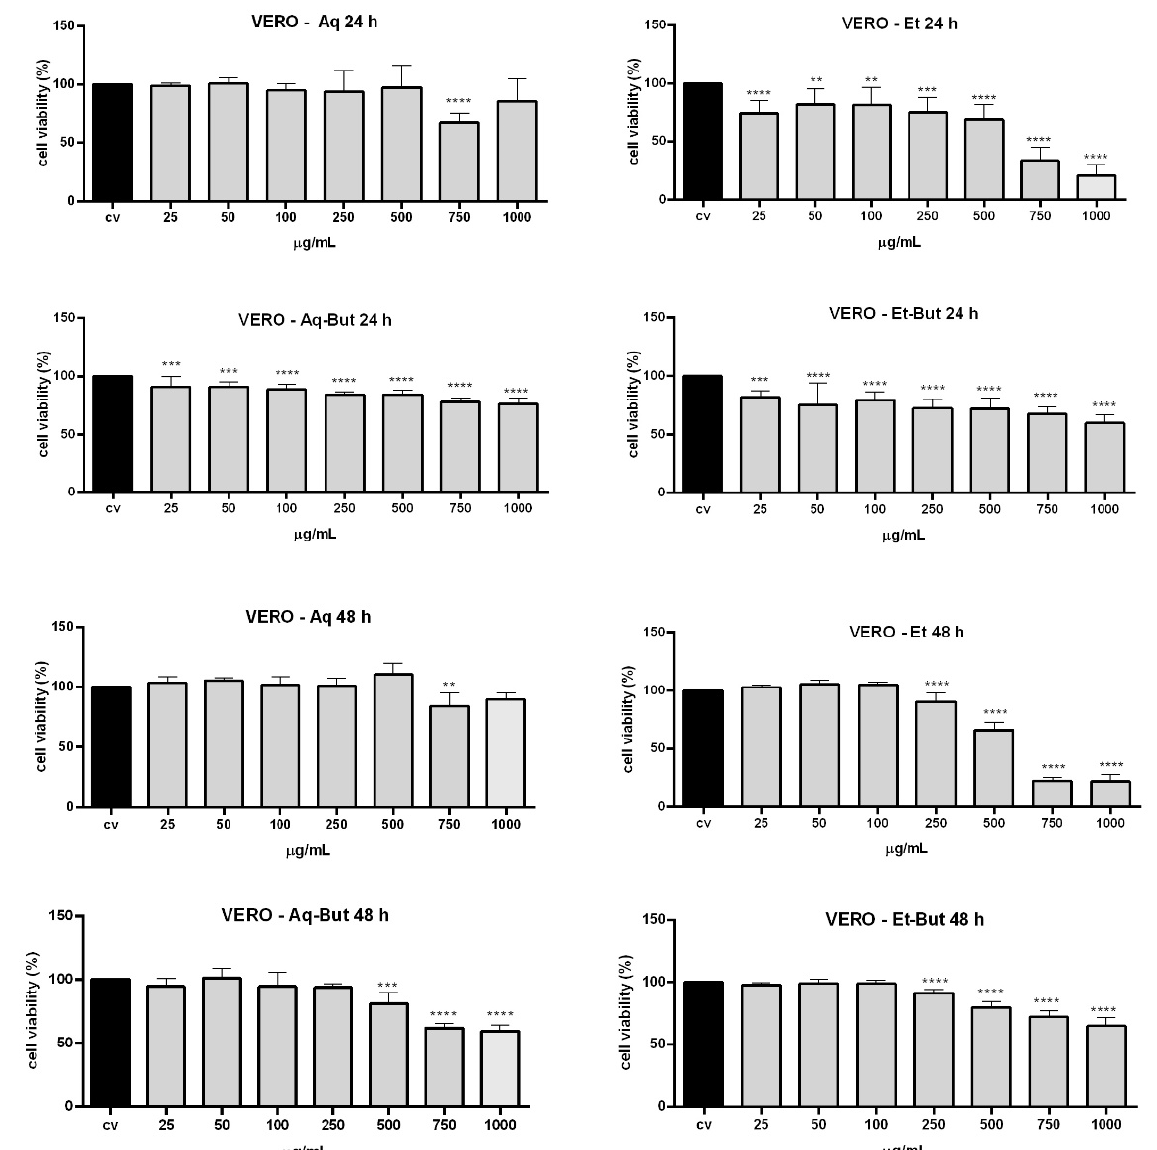
Figure 3. Cytotoxicity analysis of M. albicans extracts on Vero cells evaluated by PrestoBlue ® . Cells were incubated with aqueous and ethanolic extracts, as well as their butanol fractions (25, 50, 100, 250, 500, 750, and 1000 µg/mL), for 24 h and 48 h. Statistical analyses were performed by one-way analysis of variance (ANOVA). followed by Bonferroni’s test, for selected pairs. Results represent the mean ± SD of two independent experiments ( n = 2, in triplicate); ** p < 0.01, *** p < 0.001, **** p < 0.0001 versus vehicle control (V).